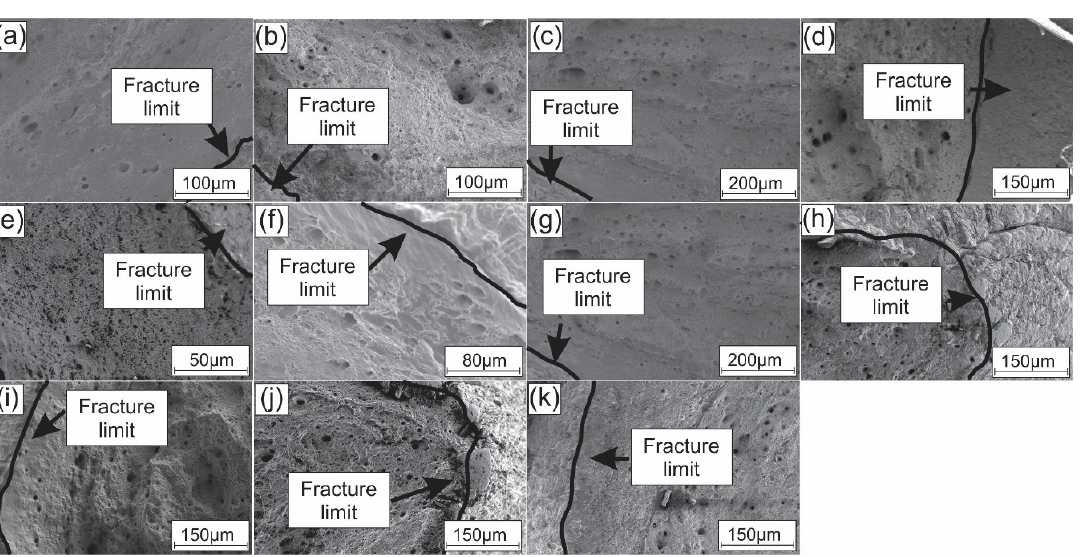
Figure 9. Fractographies of the SSRT tests taken at the edge of the fracture. ( a ) As-received in air, ( b ) as-received in bio-ethanol, ( c ) as-receives in E-50, ( d ) 30 min aged in bio-ethanol, ( e ) 30 min aged in E-50, ( f ) 1 h aged in bio-ethanol, ( g ) 1 h aged in E-50, ( h ) as-received in 1% H 2 O 10NaCl bio-ethanol, ( i ) as-received in 3% H 2 O 10NaCl bio-ethanol, ( j ) as-received in 5% H2O 10NaCl bio-ethanol, ( k ) As receives n 5% H 2 O 32NaCl bio-ethanol.